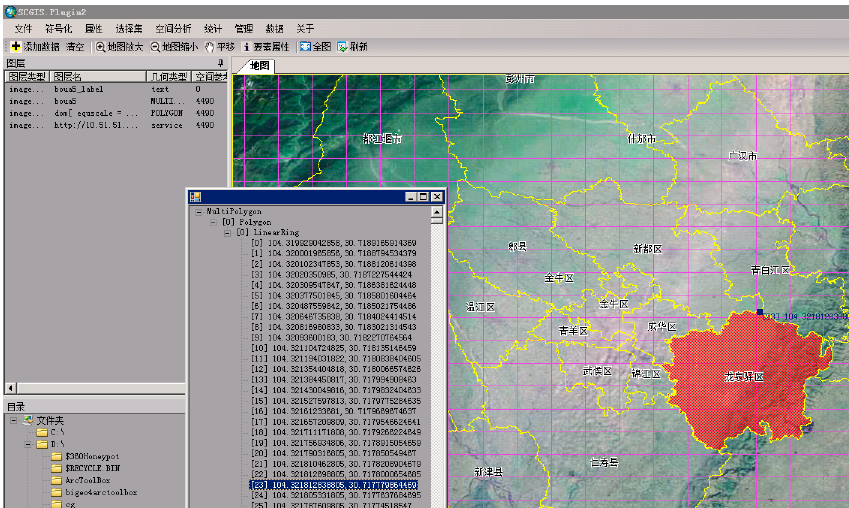
Simple line symbol, implemented in three types of parameter symbols: solid, template, and image lines SimpleFillSymbol Simple area symbol, implemented in three types of parameter symbols: fill color, template pattern, and image pattern MultiSymbol Combination symbol, implemented through a combination of various symbols by layer to form complex symbol drawing MapConfig can save map styles as JSON documents through saveMap. The map style is restored from the file through loadMap by using the map style in the JSON format. MapConfig has a clear structure and is easy to edit and exchange. When the GIS engine calls the pg data source, it will automatically adopt the most appropriate rendering strategy according to different database server types. When using a normal single-node PostgreSQL database, a fast rendering strategy is used without a complex geometry processing. When Greenplum and BiGeo data clusters are applied, the complex polygons with islands and holes are graphically displayed, hidden, and covered, and the data in the range are batch-cut to obtain better graphic display effects and efficiency. The GIS engine also uses the read-only cursor dynamic read to reduce the memory usage of the massive data of the cluster, and implements a concurrent multithread dynamic rendering mechanism. This will ensure that the rendering data and the cluster call asynchronously and can be viewed and interrupted in real time. 4.3. Desktop Desktop-side applications include data and functions including clusters for unified integration and expansion (Figure 6). This is suitable for scenarios in which the data are computationally